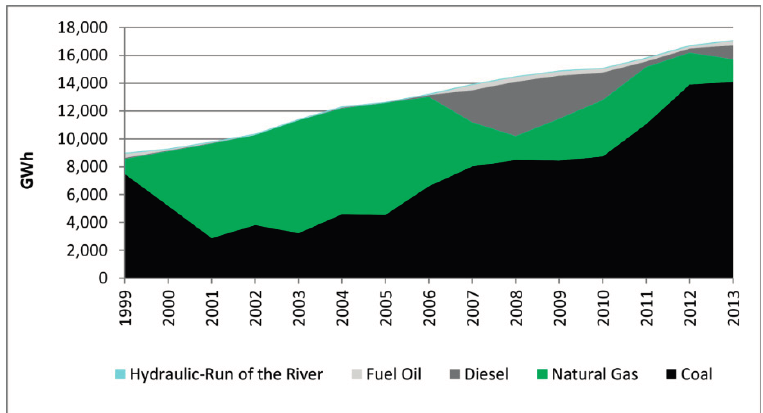
Figure 2. Electricity generation by sources, SIC 1999–2013.